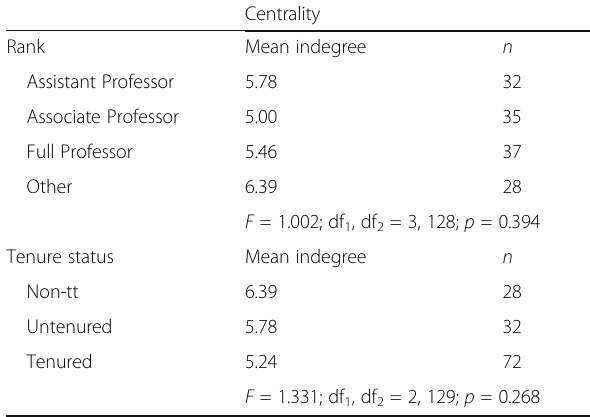
Table 5 Centrality and organizational position